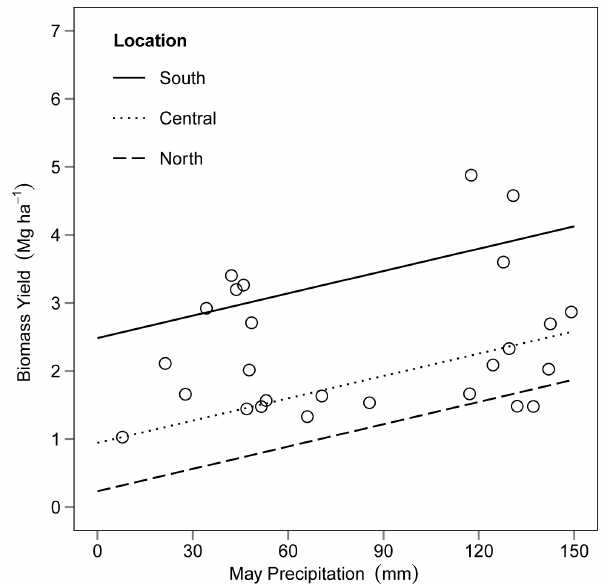
Figure 6. Estimated effect of May precipitation on biomass yield. Dots represent average measured biomass yield and May precipitation values by block. Regression lines are model estimates for bioenergy yield across the precipitation gradient for each location, with all other covariates held constant at their average values.